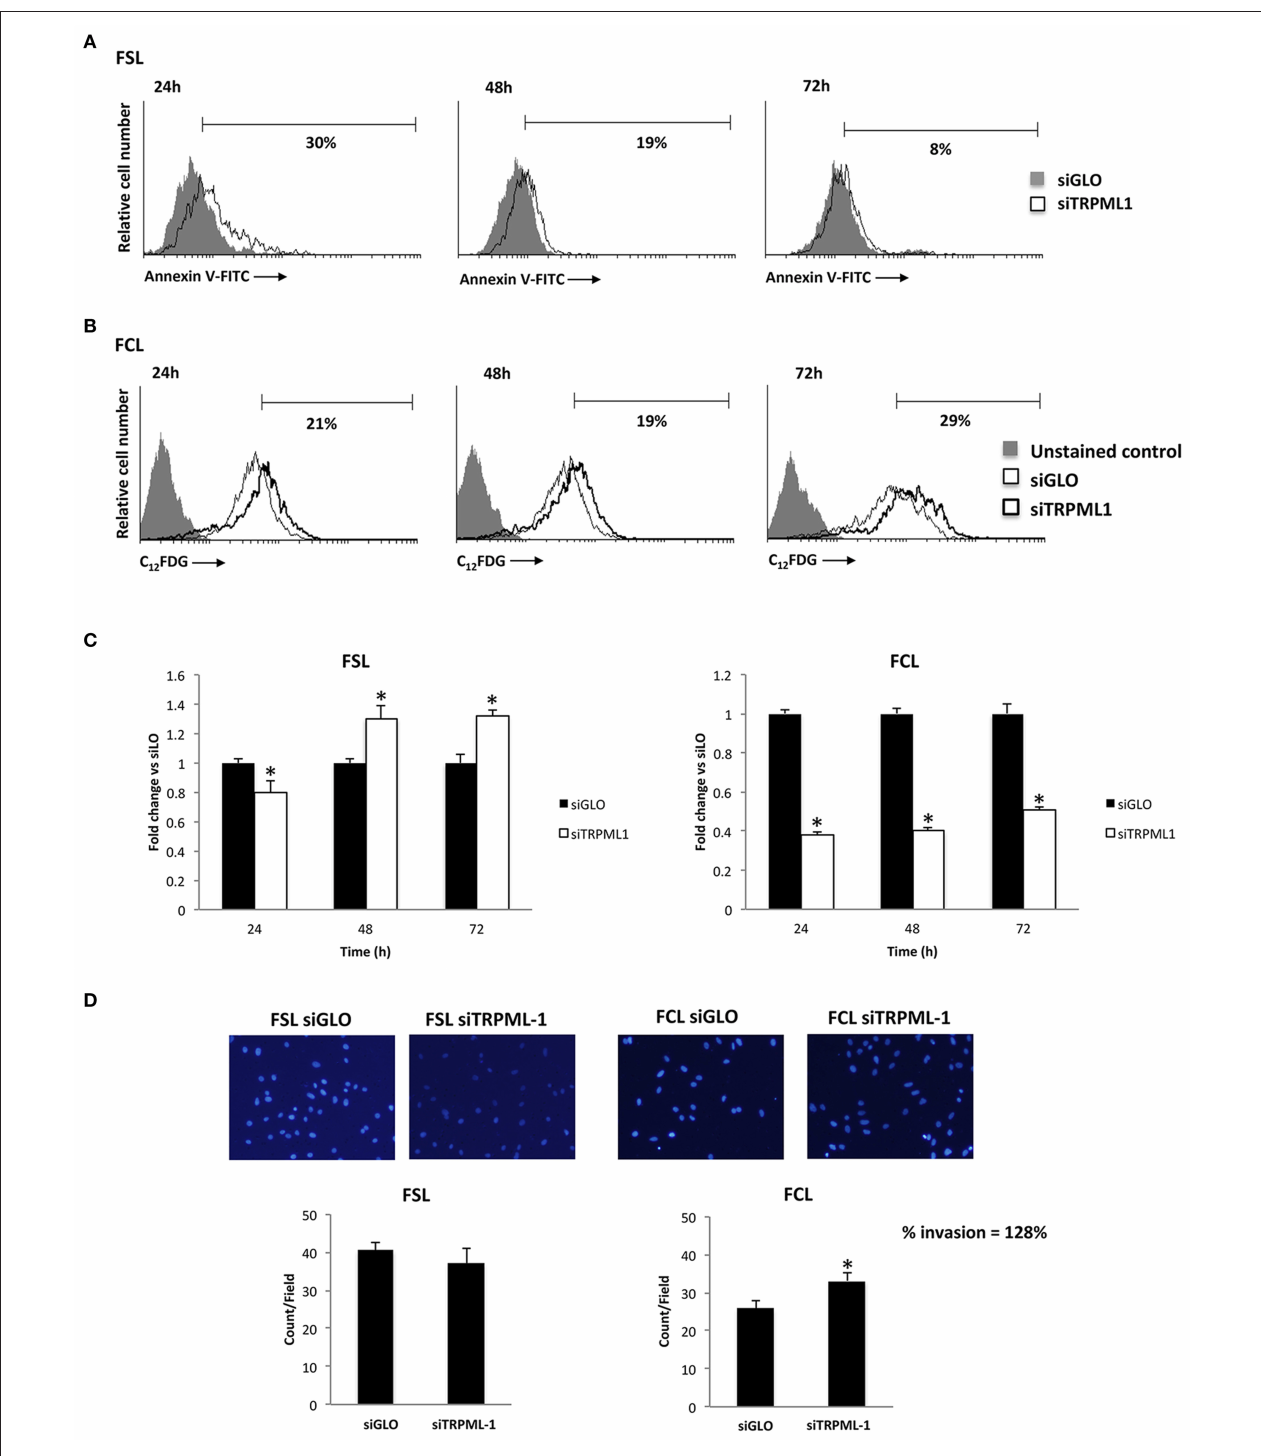
FIGURE 9 | Effects of transient receptor potential mucolipin 1 (TRPML1) silencing on patient-derived cells. (A) Annexin V staining was analyzed by flow cytometry in siGLO and siTRPML1 FSL cells for up to 72-h post-silencing. Percentages represent the positive cells. (B) Representative flow cytometric profiles of siGLO and siTRPML1 FCL cells stained with C 12 FDG. Data represent the percentage of positive cells. Gray curve represents unstained cells. (C) Fold change difference in cell proliferation of siTRPML1 cells was compared with siGLO control cells. * p < 0.05 vs. siGLO. (D) Representative images showing DAPI fluorescence after 24-h culture in Transwell chambers ( × 10 magnification). The invading cells were counted in 10 randomly chosen microscopic fields per transwell. Each sample was run in triplicate, and three independent experiments were performed. Bars represent the quantification of invaded cells in each field. Error bars represent ± SE. * p < 0.05.